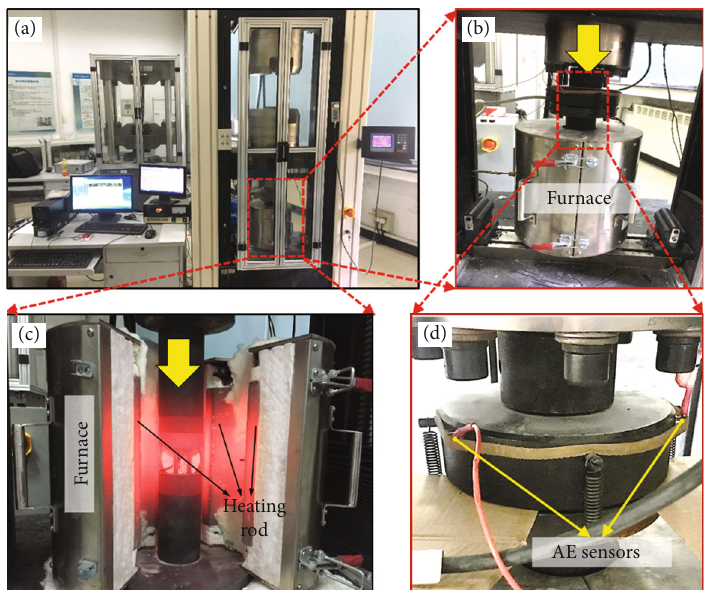
Figure 3: Photographs of the test systems showing the uniaxial compression test machine with the test control and data acquisition equipment (a), the furnace surrounding a sample (b and c) and a more detailed view of the acoustic emission sensors attached to the piston